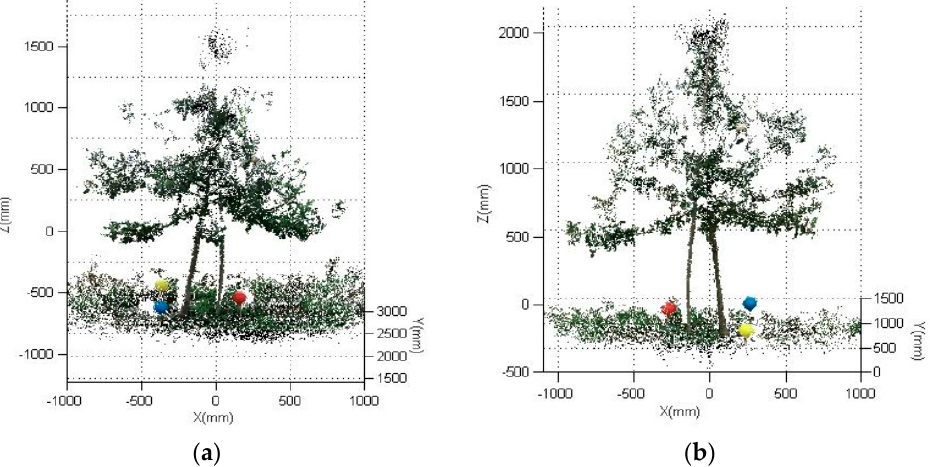
Figure 3. Point cloud image for a fruit tree under different visual angles: ( a ) point cloud coordinate: PointCloud1; ( b ) point cloud coordinate: PointCloud2.